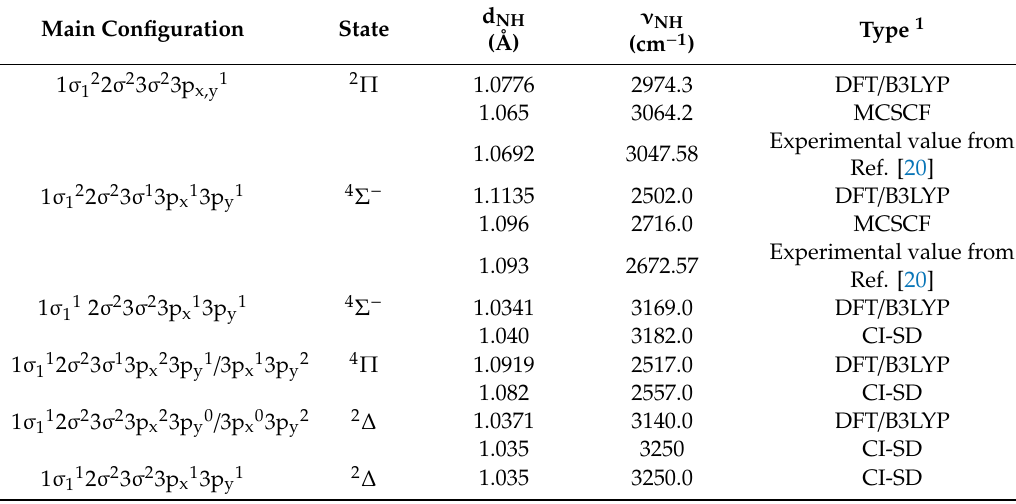
Table 1. NH + calculated internuclear distances, d NH , and frequencies, ν NH , for the 2 Π and 4 Σ − ground states compared to experiments (Reference [20]) for the N1s − 1 core-excited states located in the 394–400 photon energy region (see